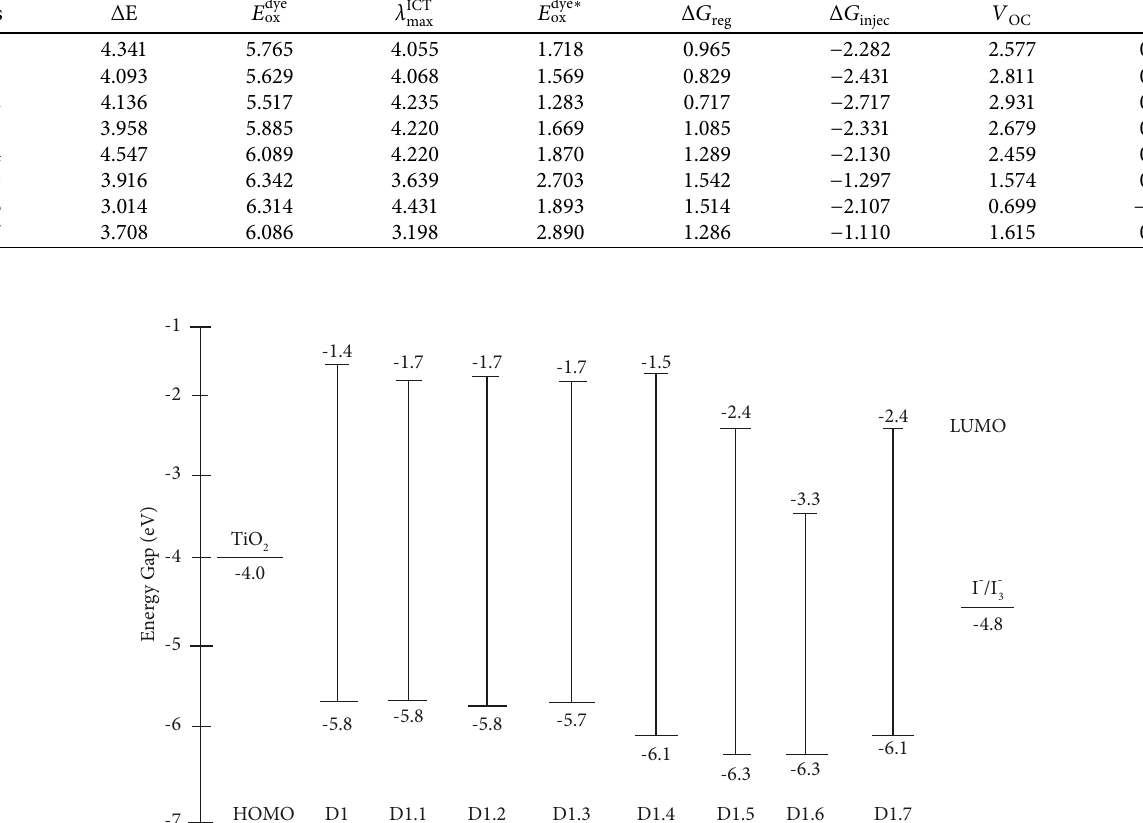
dye ∗ ox ) and excited state ( E ox ) oxidation potentials, vertical transition energy ( λ